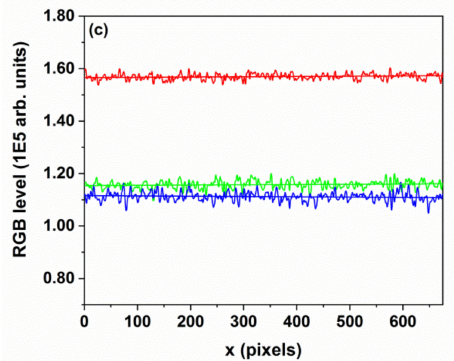
Figure 7. The color profiles extracted from the XPS chemical mapping images for: ( a ) TZN_30, ( b ) TZN_60, and ( c ) TZN_90 samples.